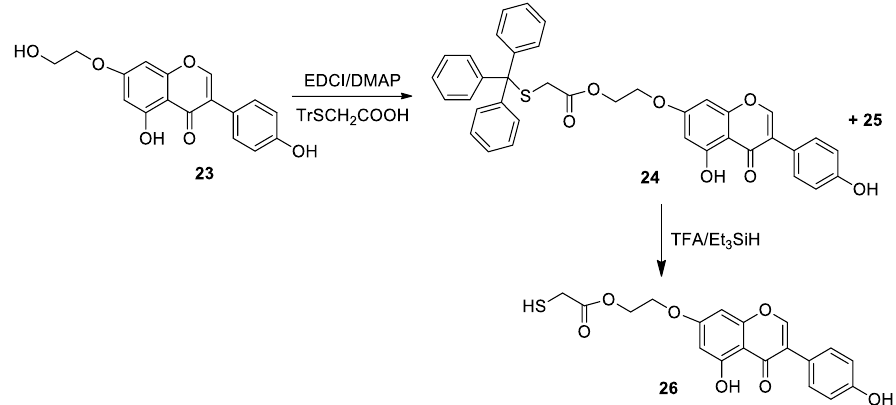
Scheme 3. Synthesis of thiol derivative of genistein.